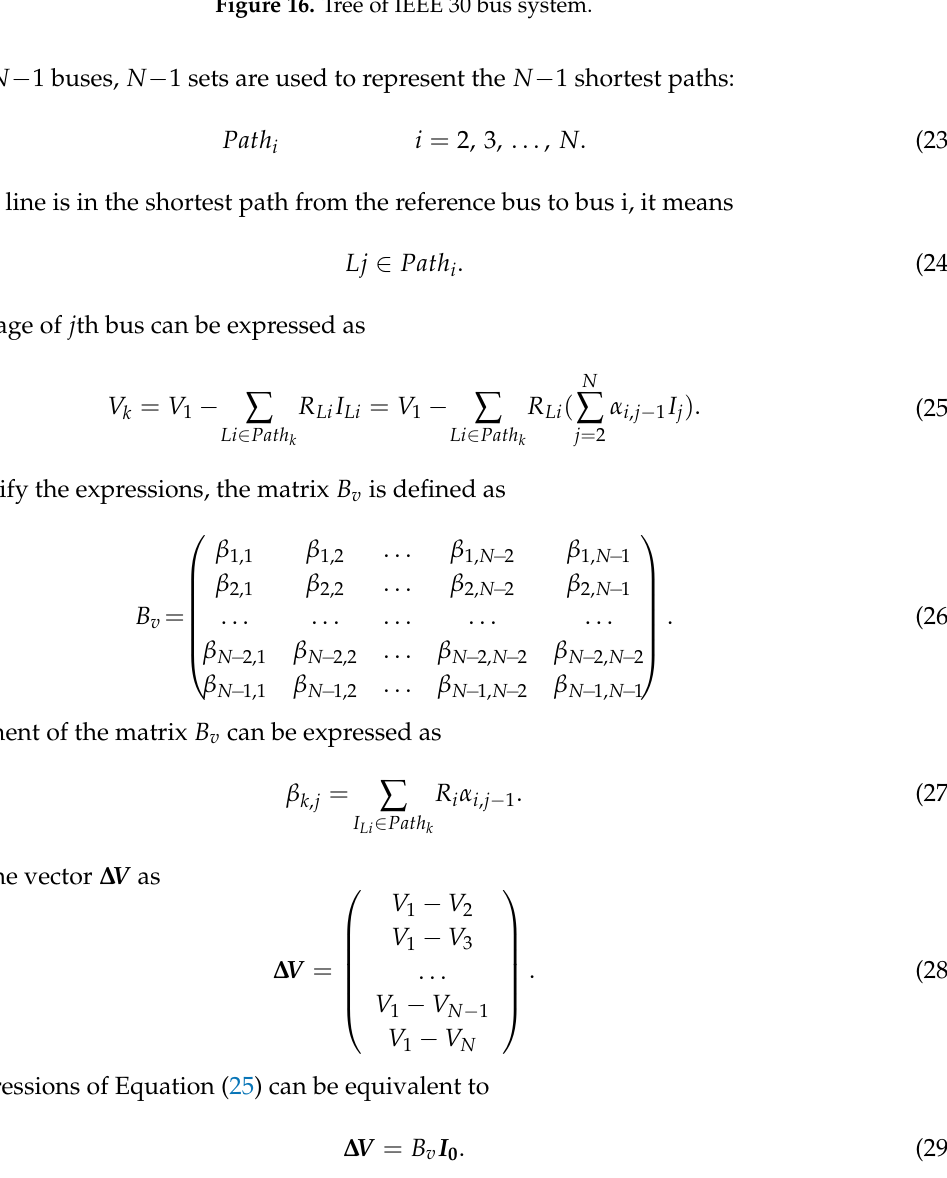
Figure 16. Tree of IEEE 30 bus